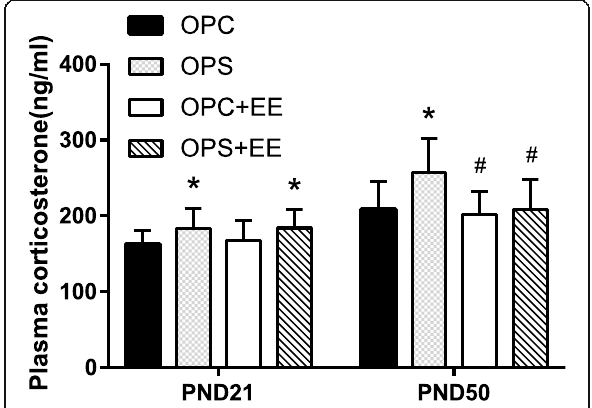
Fig. 2 The comparison of plasma corticosterone level between prenatal control group (PC group) and prenatal stress group (PS group). The figure shows that changes in plasma corticosterone level of PS were noted after stress model is established successfully. Each column represents mean ± SD. Number of animals in each group = 10. * P < 0.05 vs. PC group